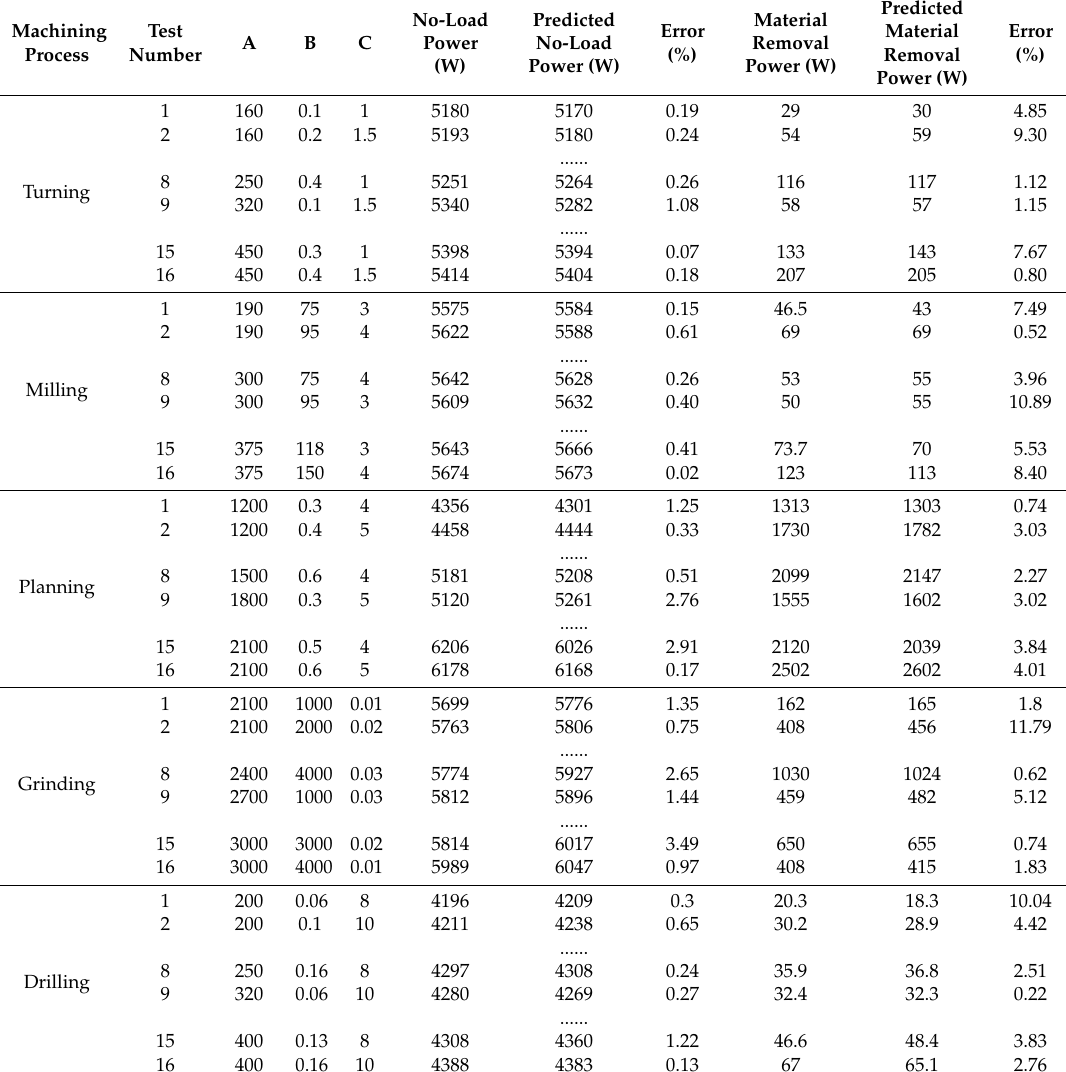
Table 2. Comparison of experimental result and predicted